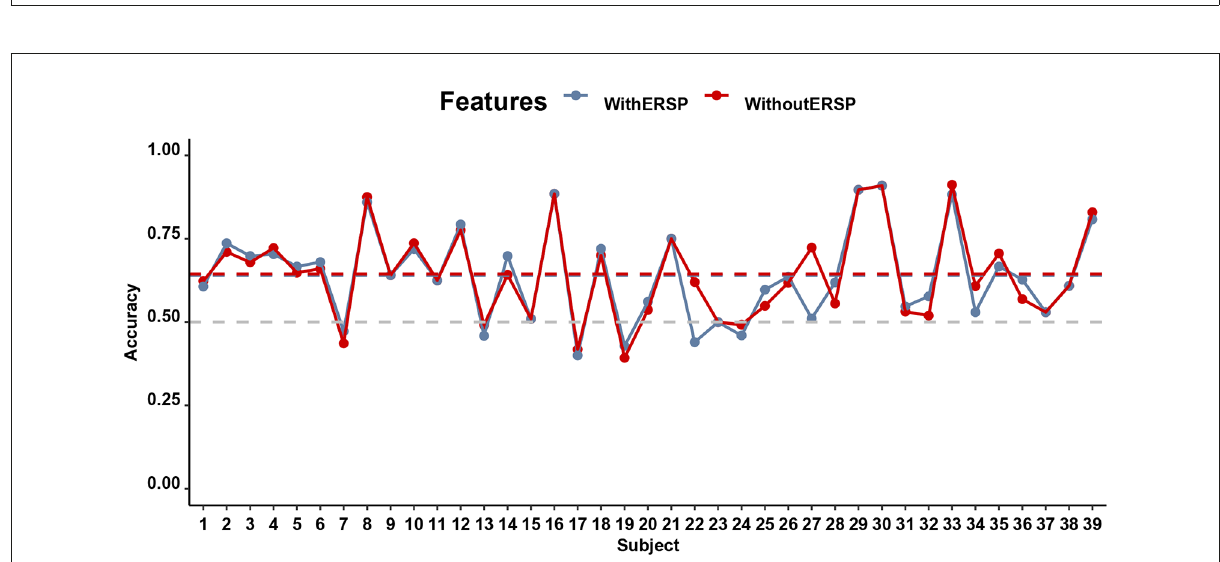
FIGURE10 Performance (Accuracy) of the SVM in the SART for all participants: prediction of whether a participant is mind-wandering or on task on the basis of various EEG features. The gray horizontal dashed line indicates the chance level of 50% accuracy while the blue and red dashed lines indicate the mean classifier accuracy with and without the ITC,